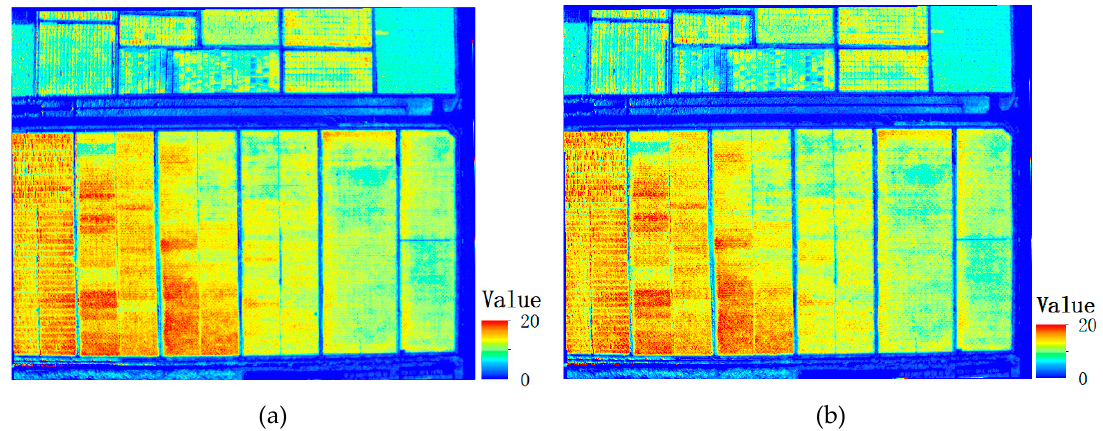
Figure 13. The LAI inversion results of calibrated images. ( a ) s the calirated image obtained by ELM and ( b ) is the calibrated image obtained by SACM.